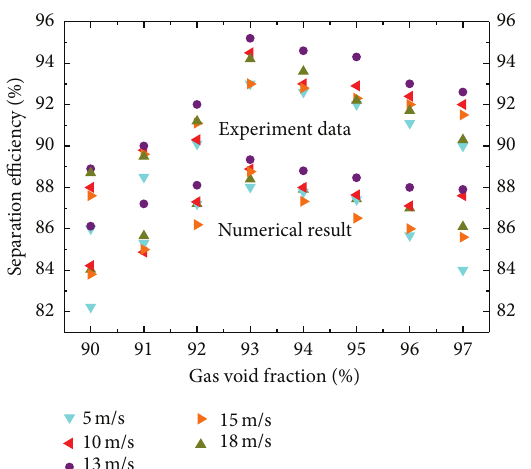
Figure 15: The comparison of separation efficiency between exper- iment data and numerical result under different velocities.